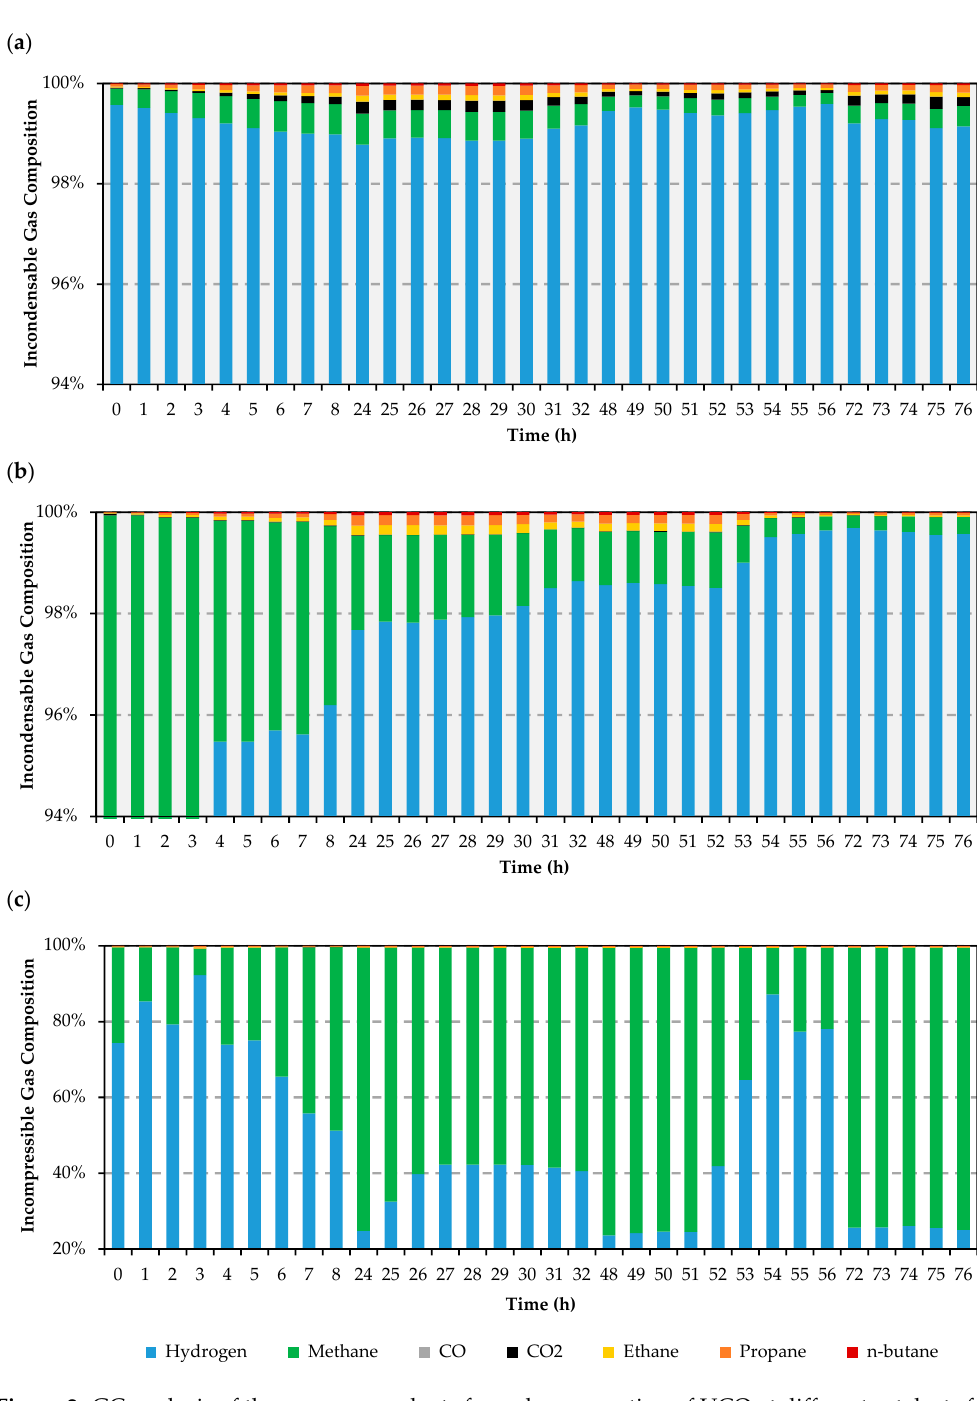
Figure 2. GC analysis of the gaseous products from deoxygenation of UCO at different catalysts for 20%Ni–5%Cu/Al 2 O 3 ( a ), 20%Ni–5%Fe/Al 2 O 3 ( b ), 20%Ni–0.5%Pt/Al 2 O 3 ( c ).